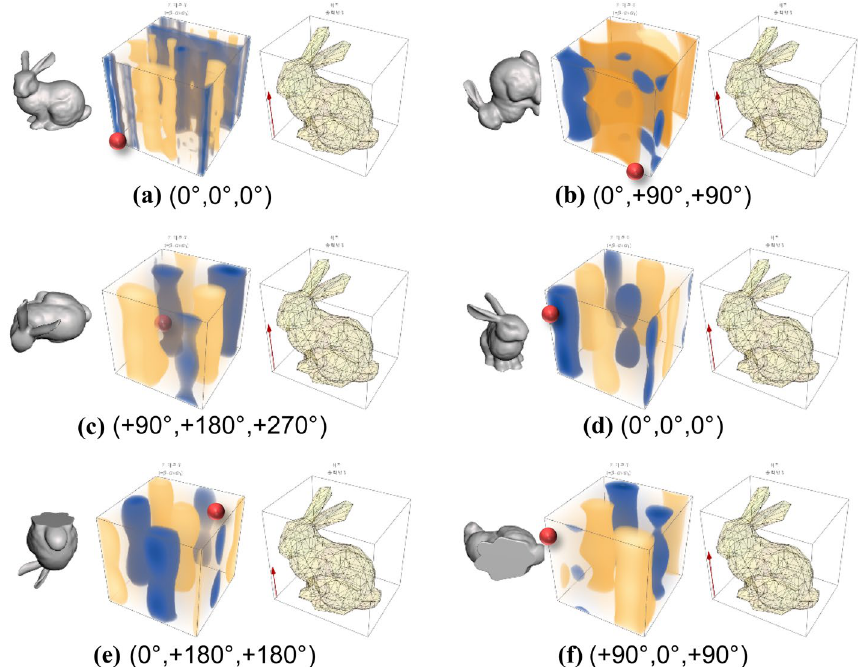
Fig. 5 Effect of initial orientation to 4D box graph (note that left-hand-side figures are the input meshes, the middle ones are 4D box graphs, and the right-hand-side ones are objects aligned to the final optimal